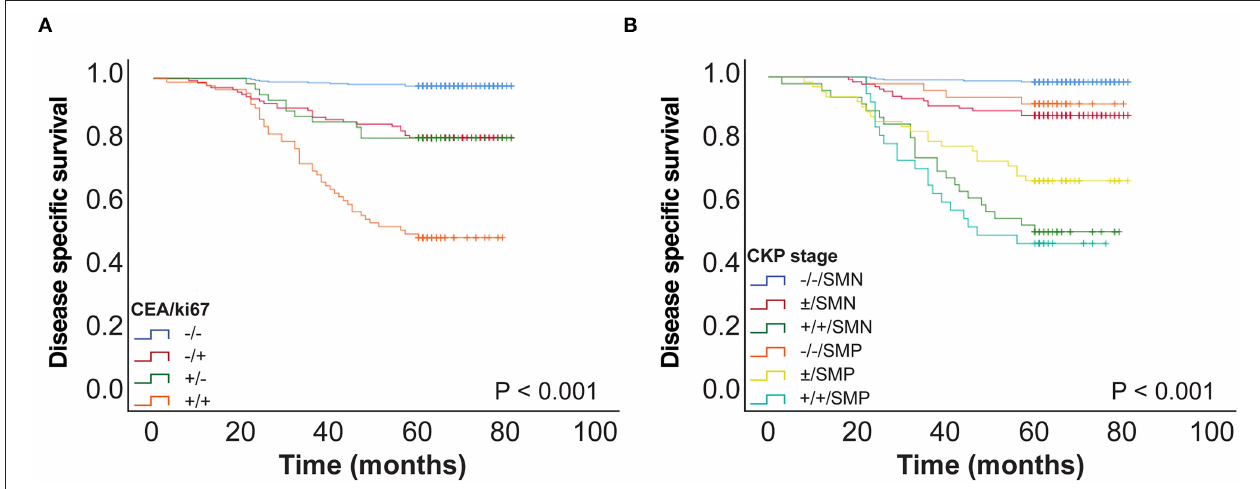
FIGURE 3 | (A) CEA and Ki-67 combined as a novel factor designated CEA/Ki-67 and 5-year DSS curve of CEA/Ki-67 in 650 patients with stage I pulmonary adenocarcinoma. (B) 5-year DSS curve of CKP in 650 patients with stage I lung adenocarcinoma. SMN, SOL-MIP negative; SMP, SOL-MIP positive.